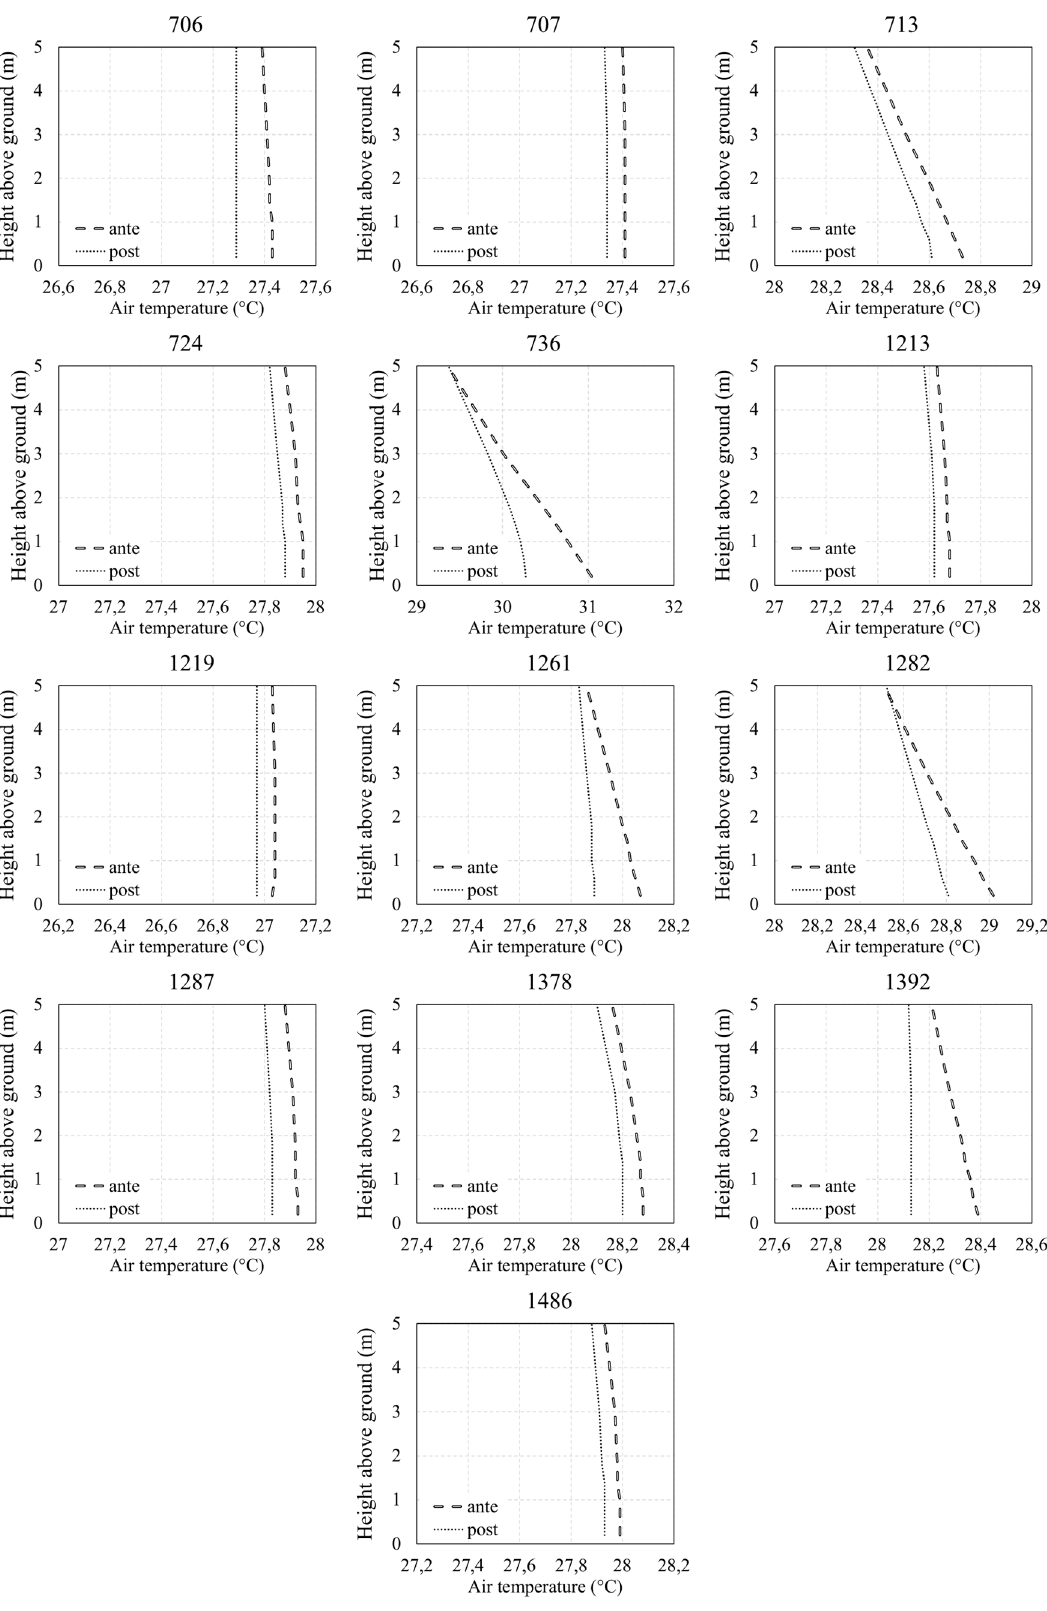
Figure 7. Altitude air temperature variations from ante to post-operam with cool materials and trees.